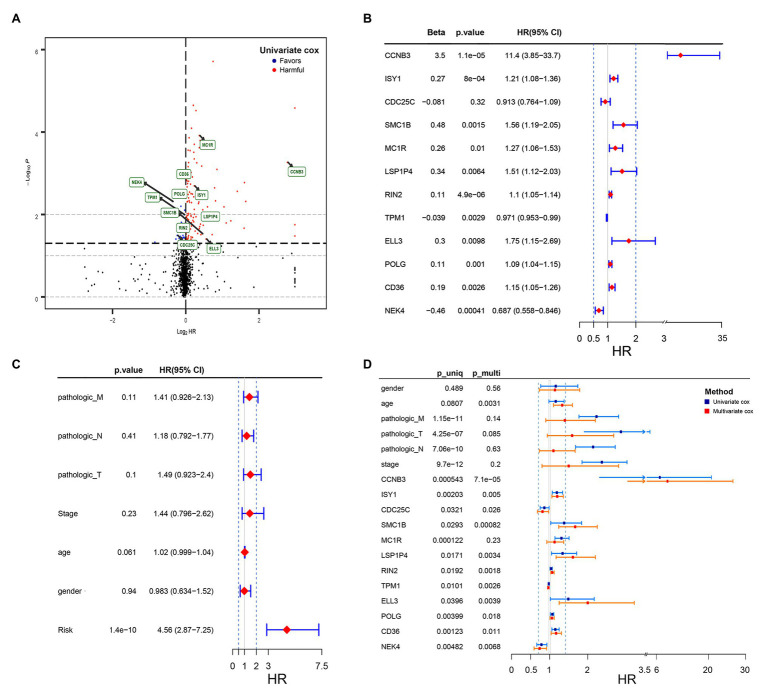
Volcano plot of DNA damage and repair related genes and forest plot of the multivariate Cox regression analysis in TCGA cohorts. (A) Volcano plot of DNA damage and repair related genes: blue indicates protective genes, red indicates harmful genes and black indicates no significance genes. (B) Forrest plot of the multivariate Cox regression analysis OS of 12 genes. (C) Forrest plot of the multivariate Cox regression analysis OS of clinical factors and risk score. (D) Forrest plot of the multivariate Cox regression analysis OS of clinical factors and 12 genes. Beta values represent the coefficient index β for each gene and clinical factors.